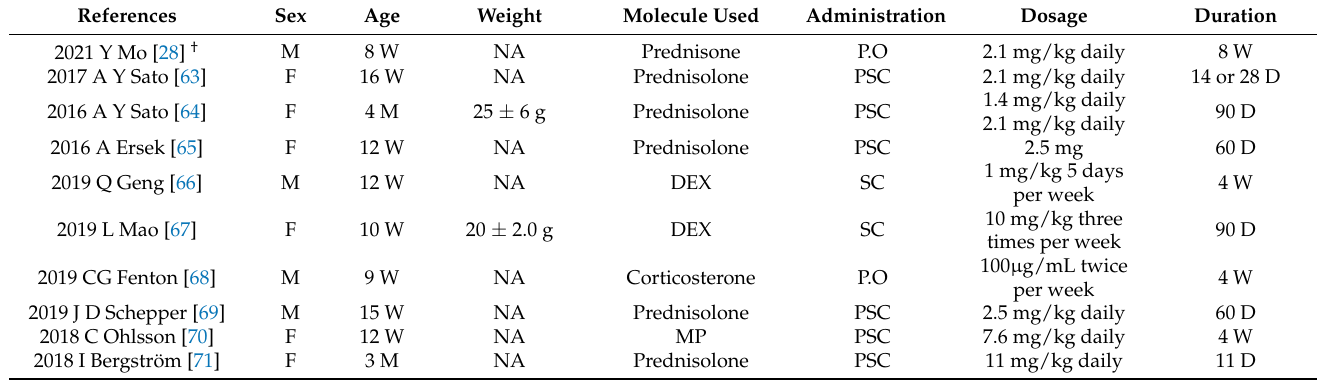
Table 6. Main characteristics of the proposed experimental protocol to induce GIOP in male and female C57BL/6 and KO derivate. M = Male, F = Female, DEX = Dexamethasone, P.O = Per. Os, PSC = Pellet in Subcutaneous, SC = Subcutaneous injection, NA = Not Available, † Study using mice and rat Sprague